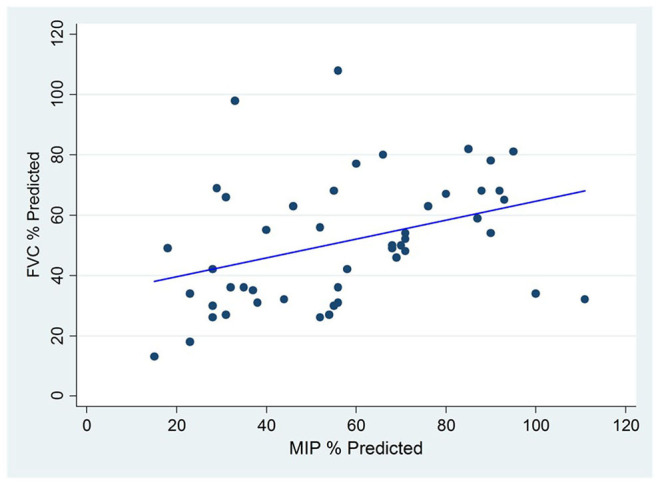
Correlation between Maximum Inspiratory Pressure (MIP) and Forced Vital Capacity (FVC) among Children with Early Onset Scoliosis without underlying neuromuscular conditions.